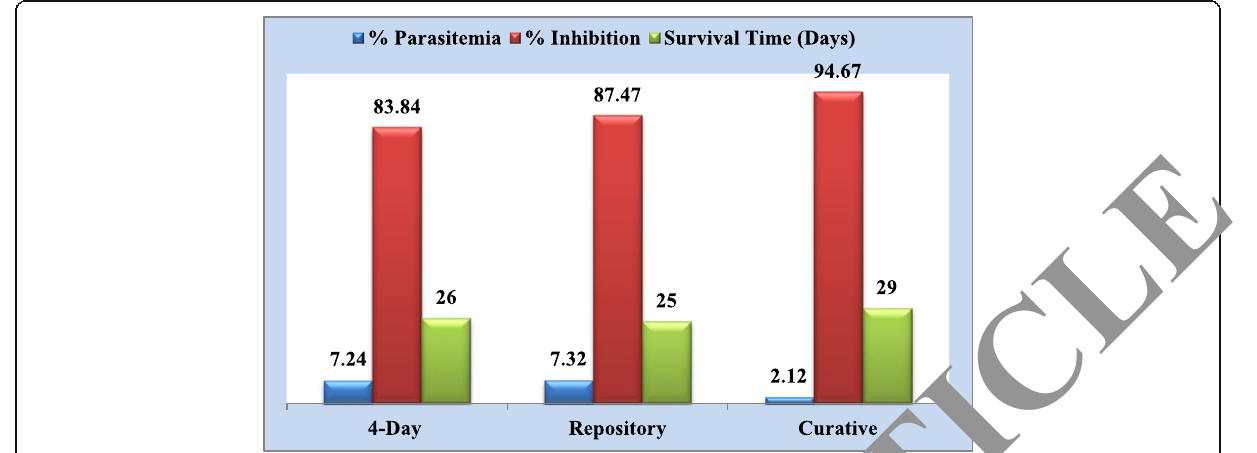
Fig. 7 Graphical representation of % Parasitemia, % Inhibition and Mean Survival Time during 4-Day suppressive, Repository and Curative tests after administration of methanolic bark extract of Pongamia pinnata at 1000 mg/kg